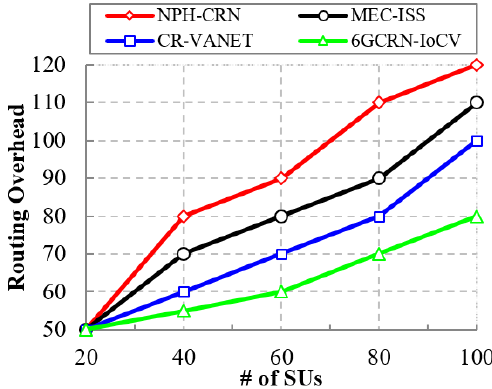
Figure 13. Routing overhead vs. the number of